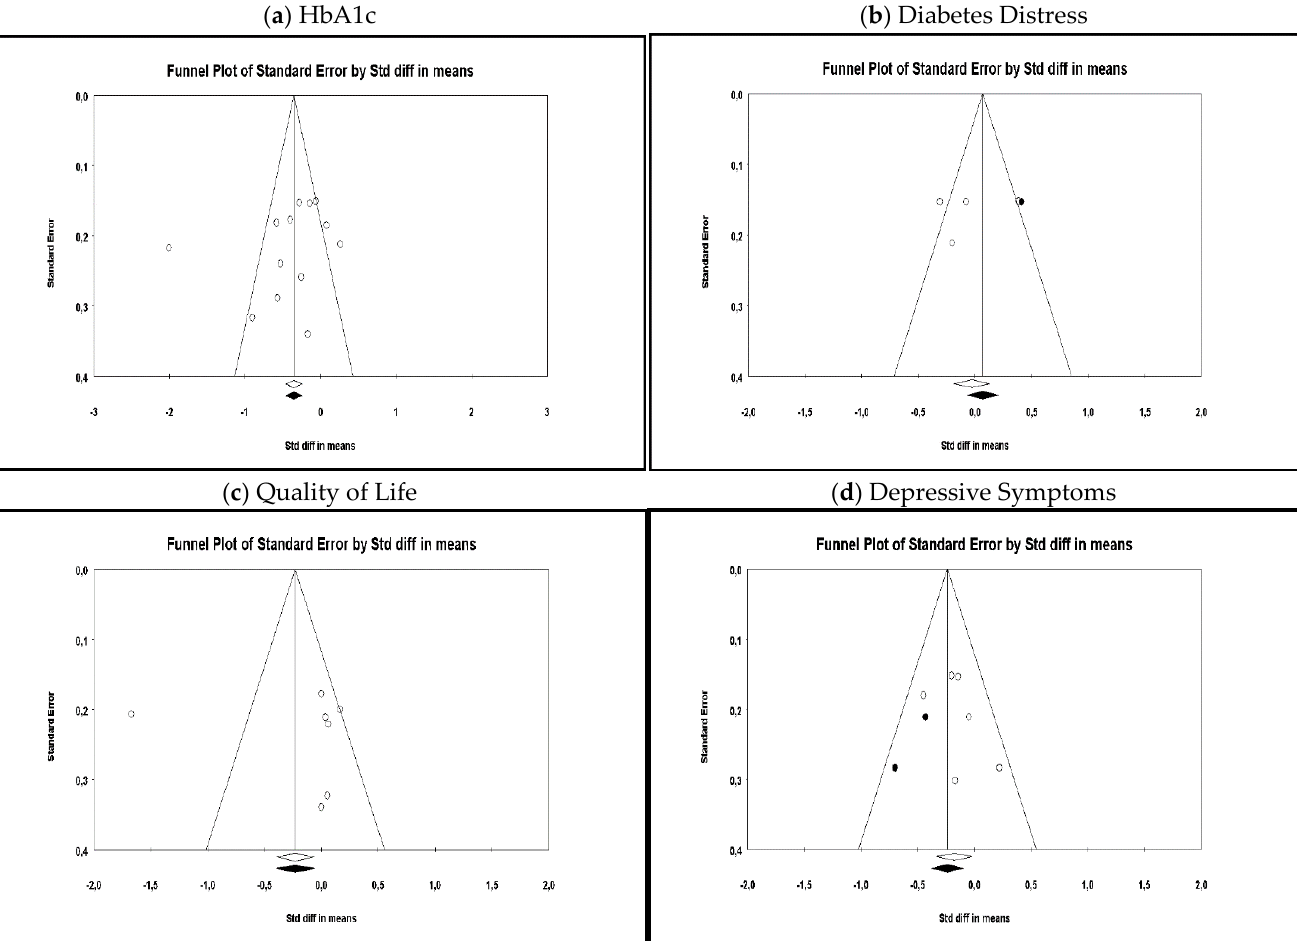
Figure 4. Depressive symptoms at the endpoint. Note. SD = Standard Deviation; Std. Mean Difference= Standard Mean Difference; CI = Confidence Interval; df = degrees of freedom.